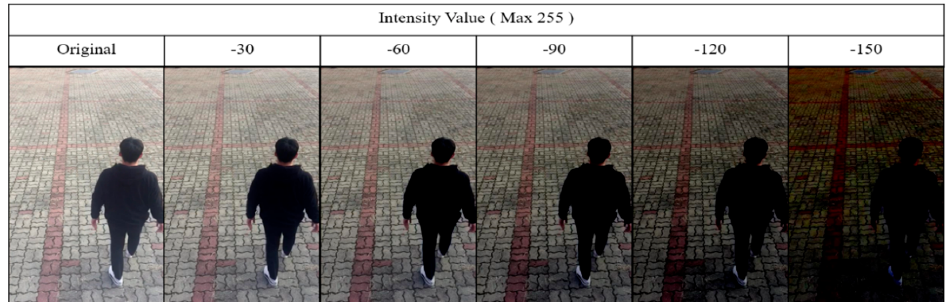
Figure 19. Testing images synthetically generated by reducing the pixel intensity for illumination changes.